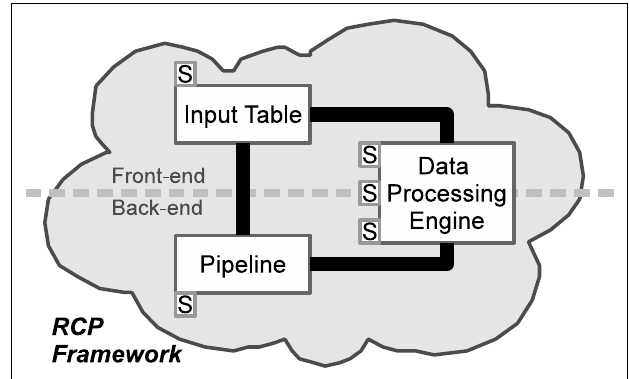
FIGURE 4 | Conceptually, CamBAfx application is constructed from of three components: Pipeline, Input Table and Data Processing Engine, integrated inside the Eclipse Rich Client Platform (RCP) framework. Minimal communication between each component allows components to be replaced or removed. The separation between front-end (user interface) and back-end can be reconfi gured as needs change. “S” denotes supporting functions which can be attached to the application as plug-ins.